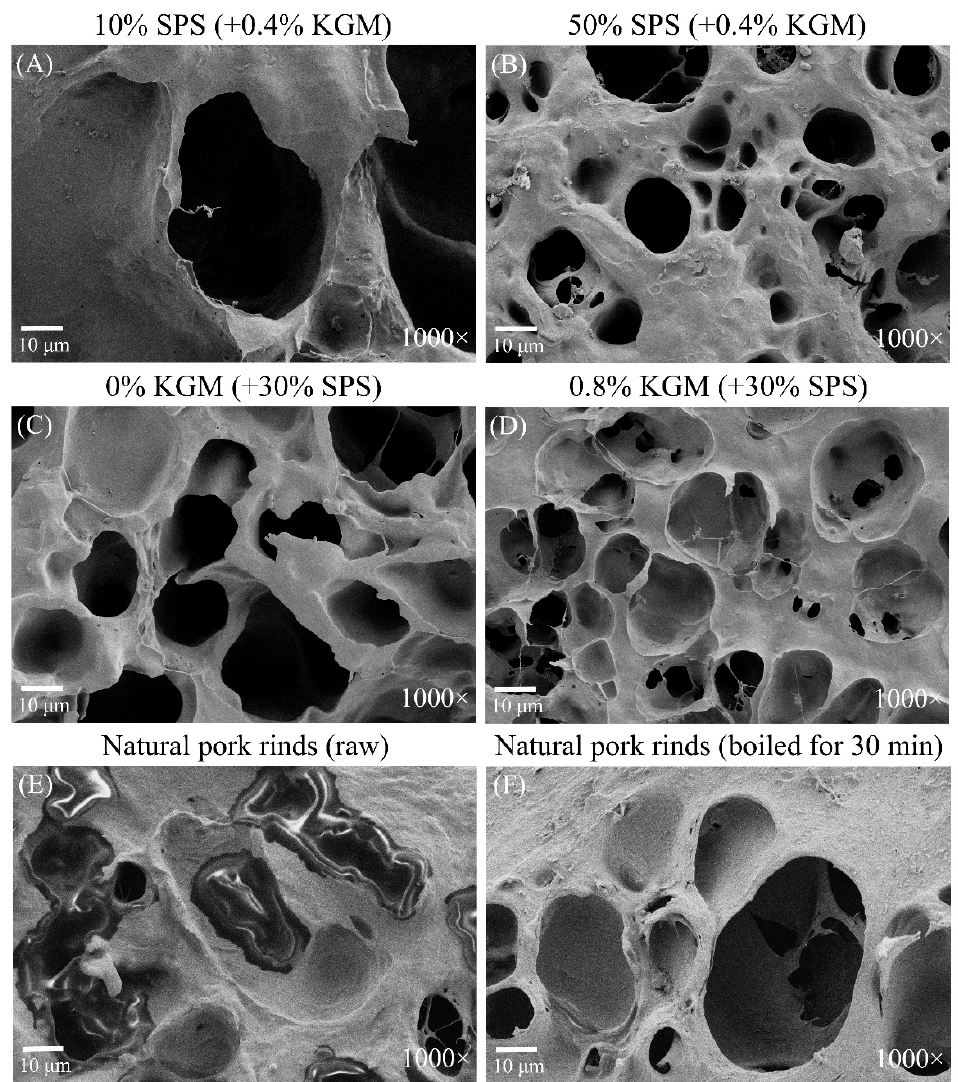
Figure 5. The microstructures of the plant-based pork rinds containing different SPS ( A , B ) and KGM ( C , D ) concentrations and natural pork rinds ( E , F ).